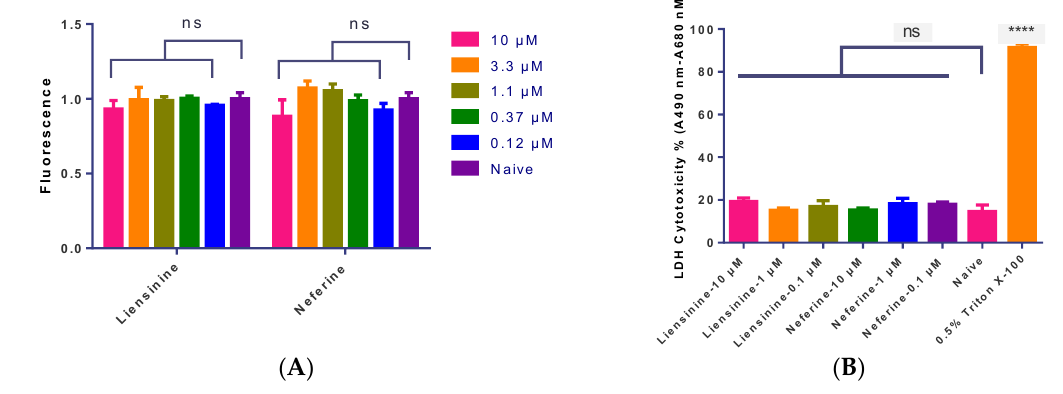
Figure 5. ( A ) A luciferase coupled ATP quantitation assay was used to determine the cytotoxicity of liensinine and neferine. Compounds were incubated in hiPS-CMs for 24 h before luminescence signal measurement; ( B ) Determination of LDH cytotoxicity of liensinine and neferine in hiPS-CMs. hiPS-CMs were plated in a 96-well plate in maintaining medium. Different concentrations of liensinine and neferine were added to the culture media and incubated for 24 h at 37 ˝ C, 5% CO 2 . LDH